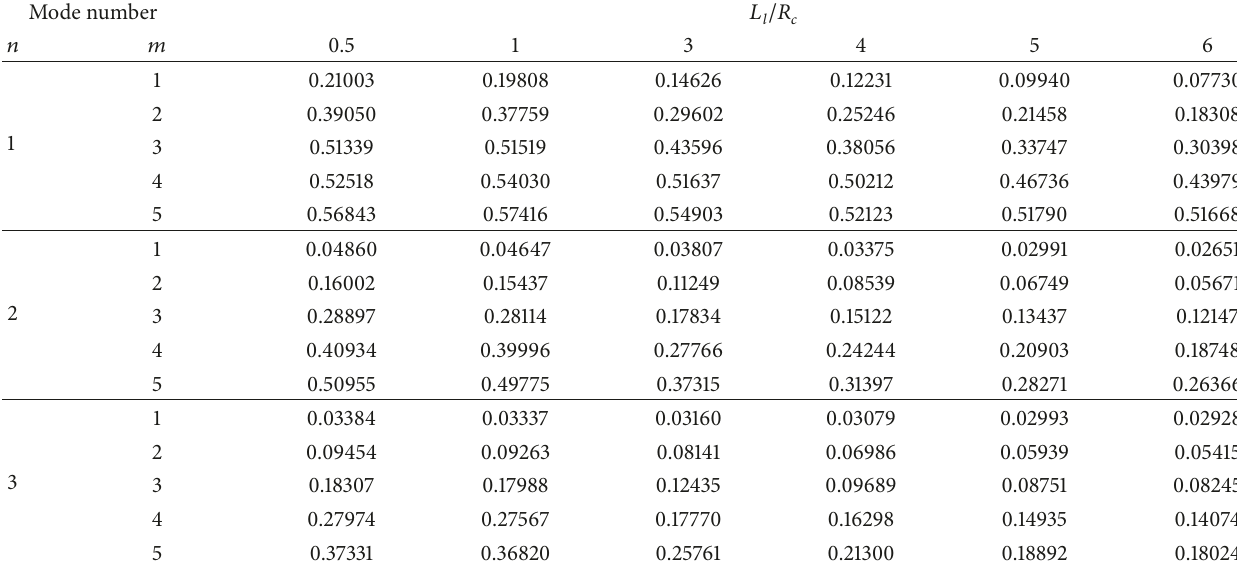
Table 4: The frequency parameters Ω of the PCE